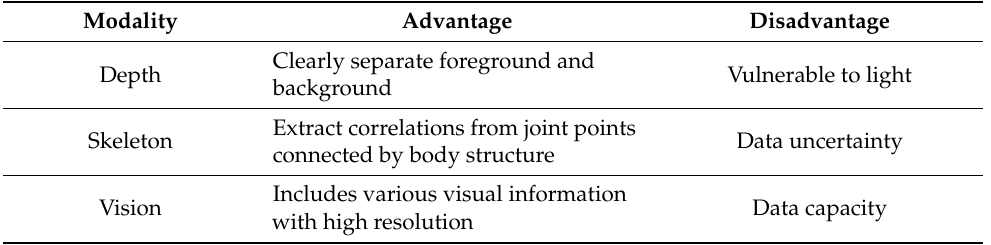
Table 1. Comparison of advantages and disadvantages of data modality for behavior recognition.